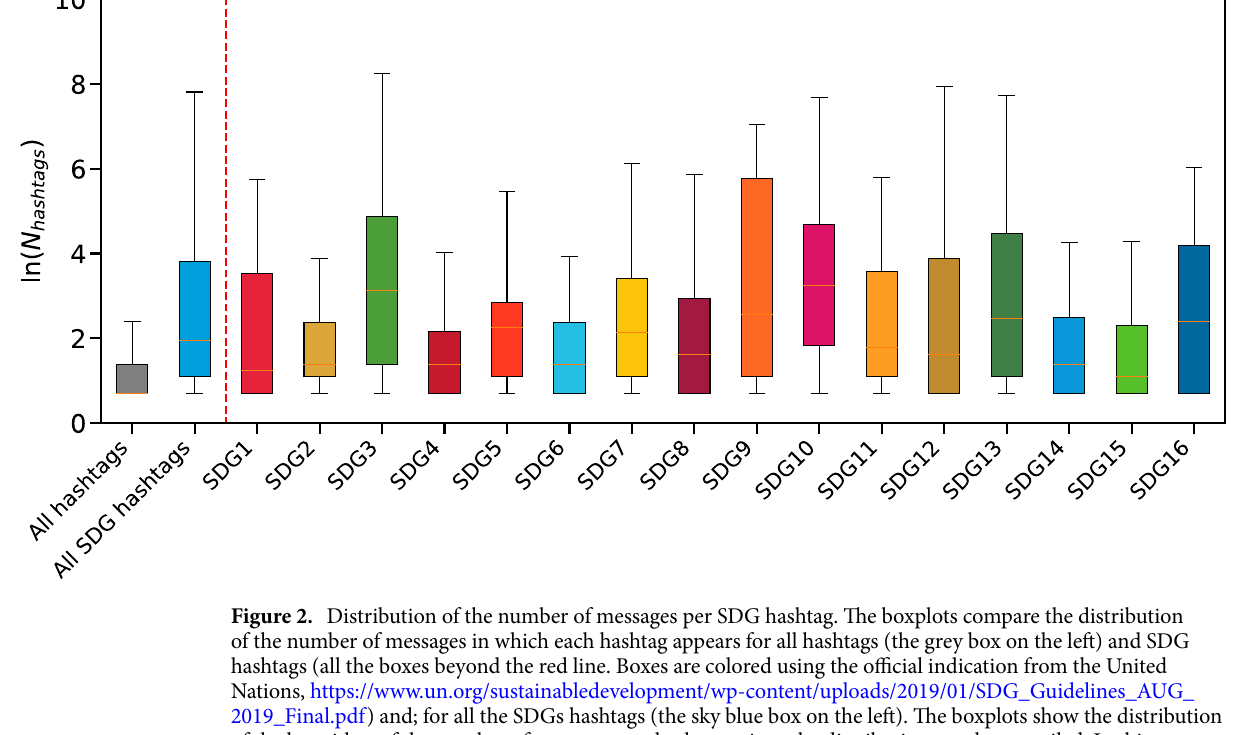
Figure 2. Distribution of the number of messages per SDG hashtag. The boxplots compare the distribution of the number of messages in which each hashtag appears for all hashtags (the grey box on the left) and SDG hashtags (all the boxes beyond the red line. Boxes are colored using the official indication from the United Nations, https:// www. un. org/ susta inabl edeve lopme nt/ wp- conte nt/ uploa ds/ 2019/ 01/ SDG_ Guide lines_ AUG_ 2019_ Final. pdf) and; for all the SDGs hashtags (the sky blue box on the left). The boxplots show the distribution of the logarithm of the number of messages per hashtags, since the distributions are heavy-tailed. In this sense, boxplots may not be the perfect tool for capturing the distribution properties but can effectively deliver the message about the rough differences among the various distributions. In particular, SDGs hashtags appear more frequently than “standard” hashtags in the communication strategy of large firms, thus representing crucial